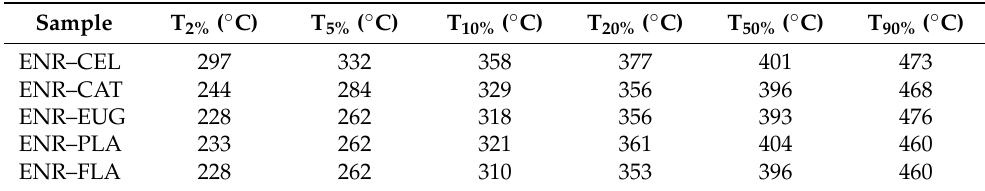
Table 2. Temperatures of the tested 50% epoxidized natural rubber (ENR-50) samples weight loss. T x% is the temperature at which the weight loss is